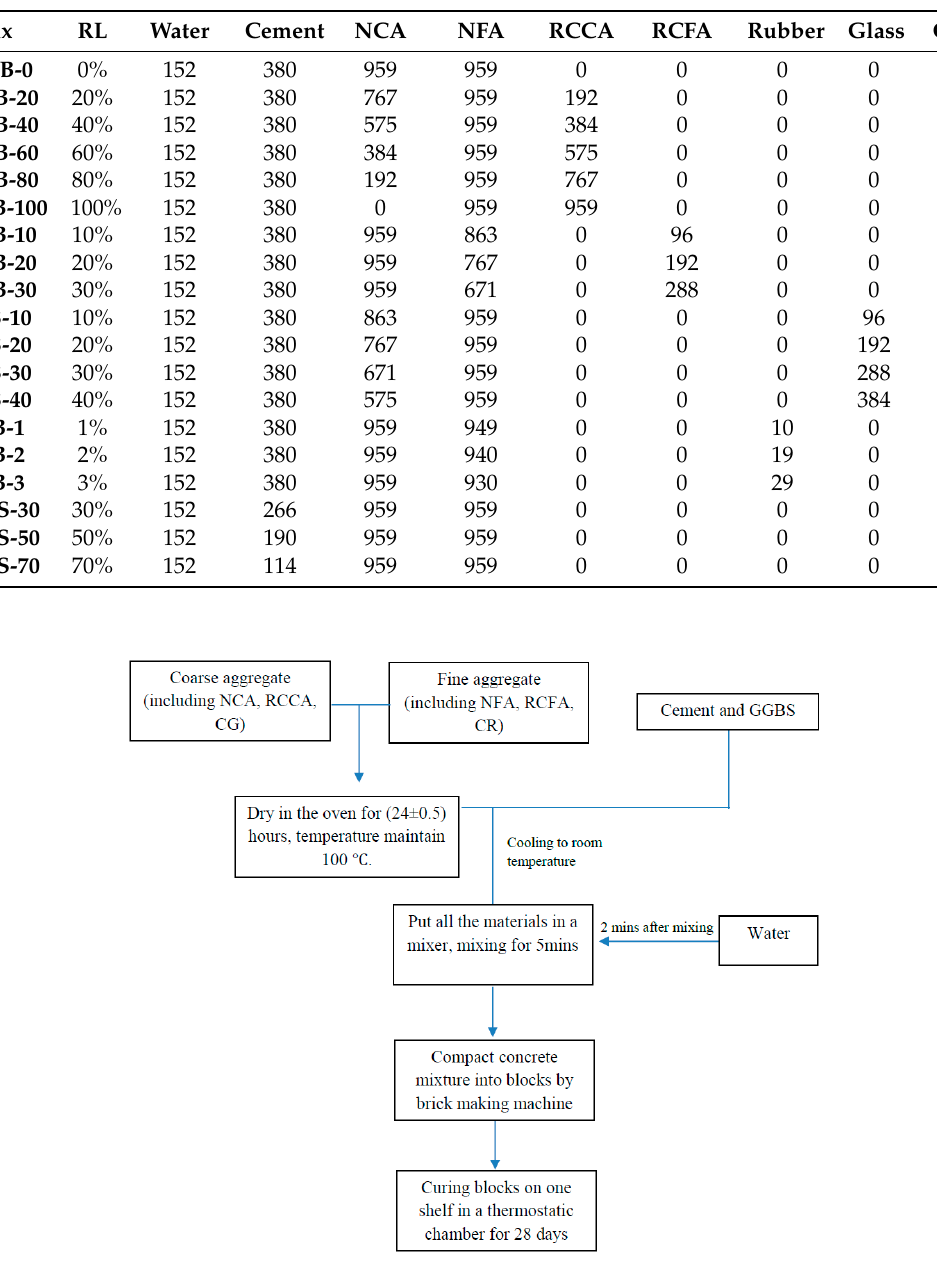
Table 4. Mix proportions (kg/m 3 ) of concrete paving blocks.